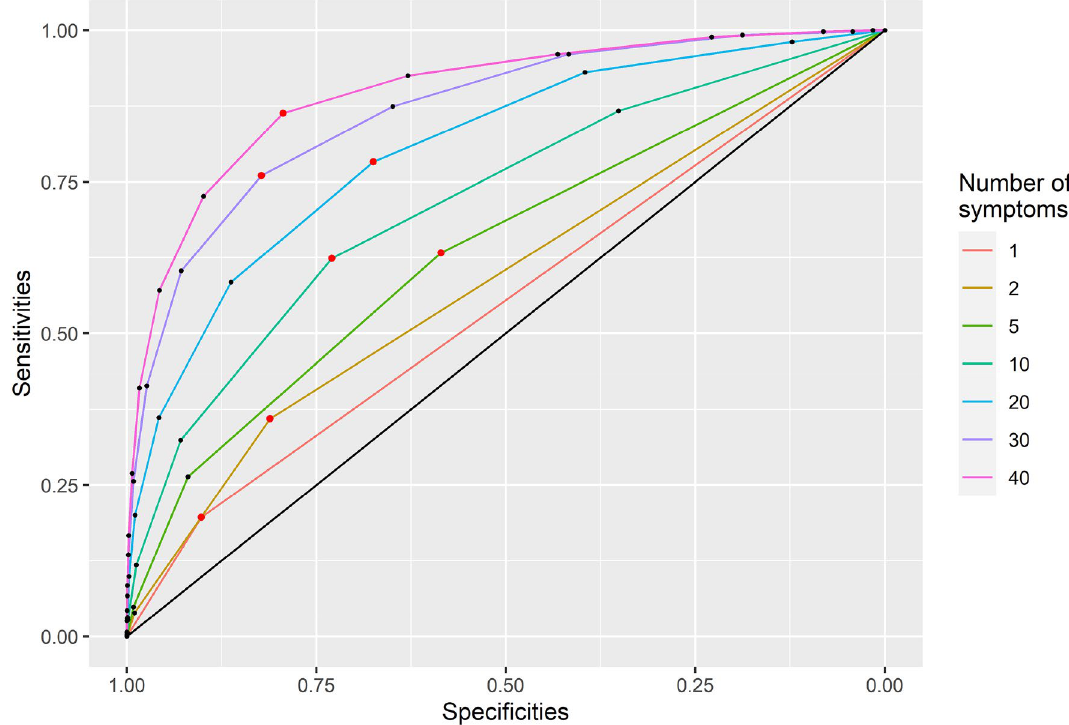
Figure 3. Receiver operating characteristic (ROC) curves for disease diagnosis based on the numbers of symptoms. Red dots = the set of sensitivities and specificities with the largest difference in the absolute values between 1 and the sums of sensitivities and specificities in a ROC curve. For each number of symptoms used for disease diagnosis, one red dot—a best set of sensitivities and specificities—was selected. With a maximum of 40 symptoms used for disease diagnosis, ROC curves in this figure were created assuming the risk ratio as 2, baseline symptom incidence as 0.1, proportions diseased as 0.05, no correlations between diseases, and no correlations between